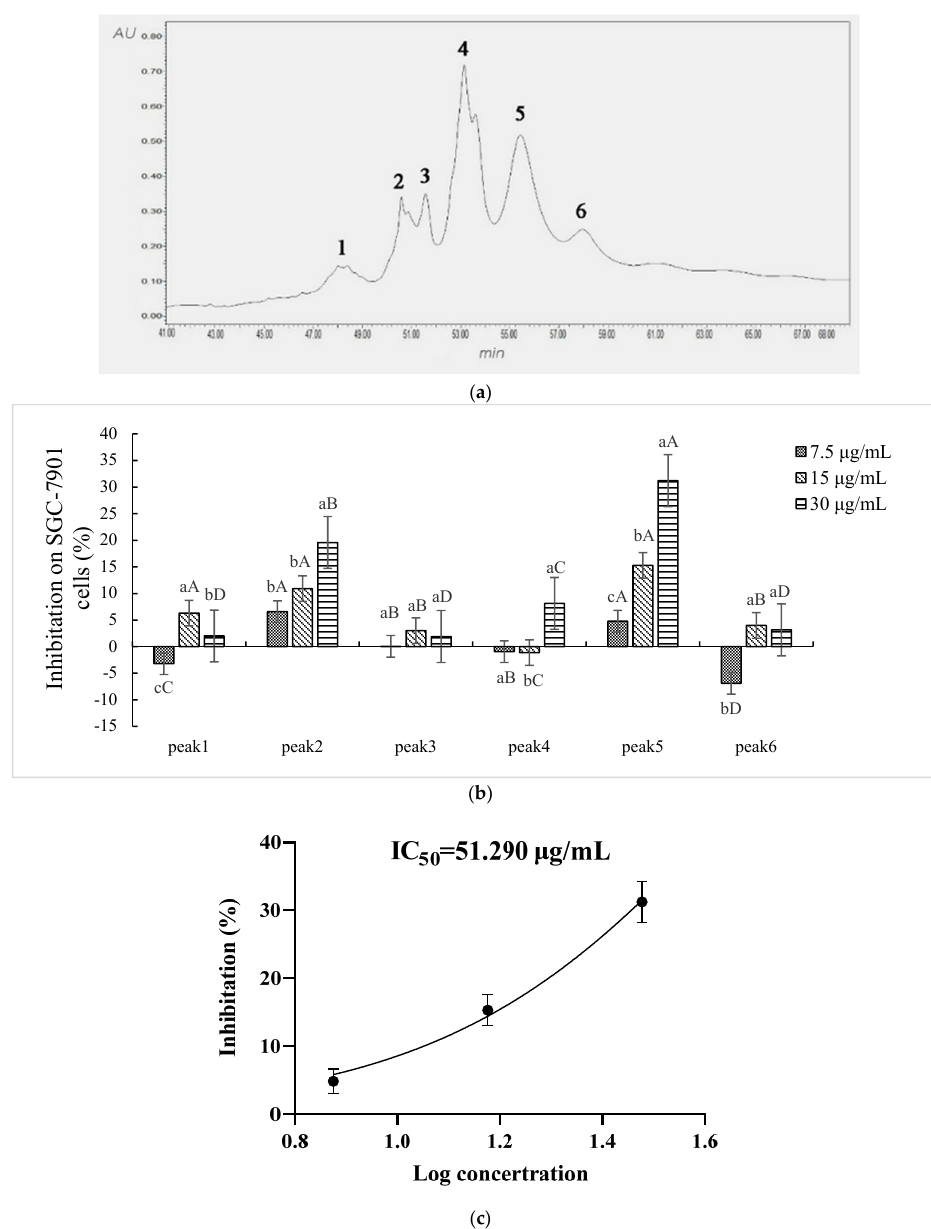
Figure 4. Inhibition effect of components separated by RP-HPLC. ( a ) The elution curve of RP-HPLC. ( b ) Inhibitory rates of cell proliferation (SGC-7901 cells) induced by Sect. II-3-3-1~6 that were separated by RP-HPLC after 48 h treatment. a, b, c means p < 0.05; A, B, C, D means p < 0.01. ( c ) IC 50 curve fitting of Sect. II-3-3-5.